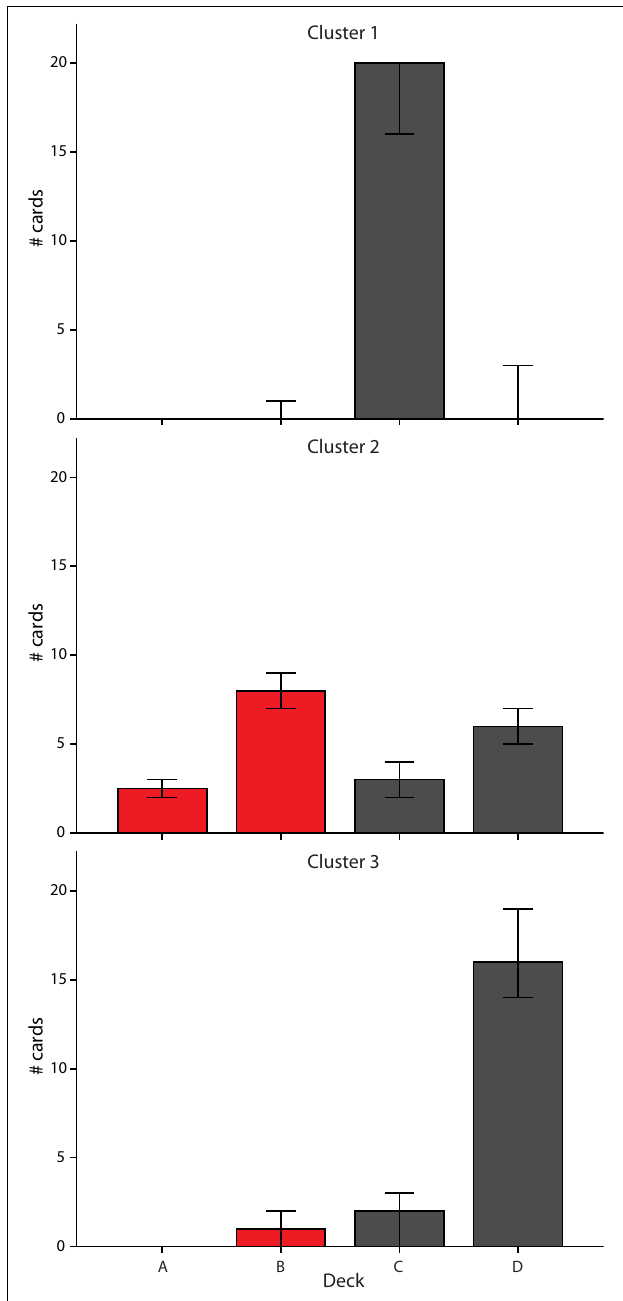
FIGURE 6 | Pattern of card selection for each cluster identified in block 5 (trials 81–100). Bars represent the median number of cards selected from each deck (with 95% confidence